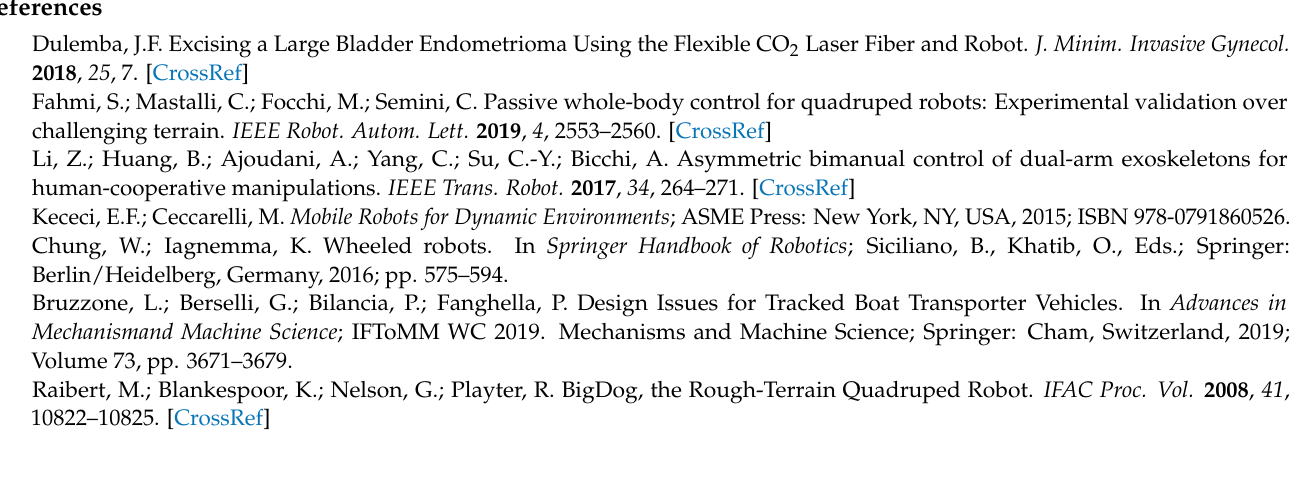
Figure 32. Vehicle climbing stairs experiment. ( a ) Side view of vehicle climbing stairs ( b ) Top view of vehicle climbing stairs